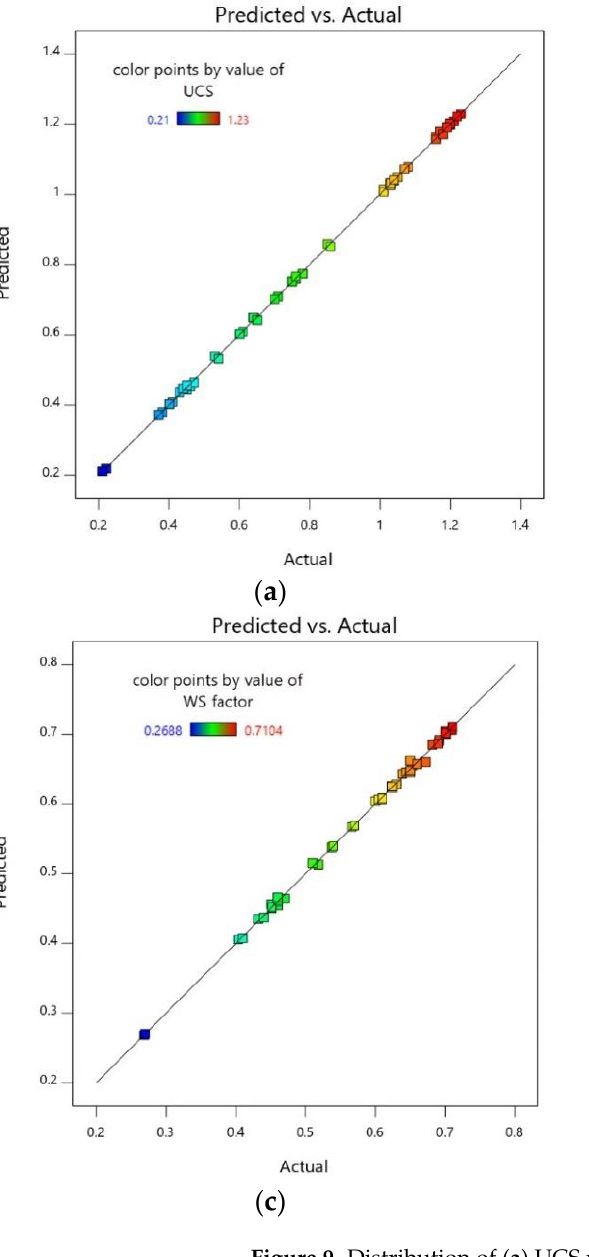
Figure 9. Distribution of ( a ) UCS predicted value and test value, ( b ) CBR predicted value and test value, ( c ) WS factor predicted value and test value, ( d ) WD factor predicted value and test value. Table 4. The results of variance